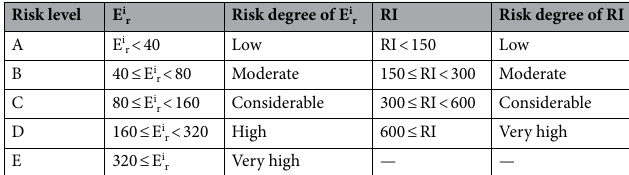
Table 2. Classification standard of potential ecological